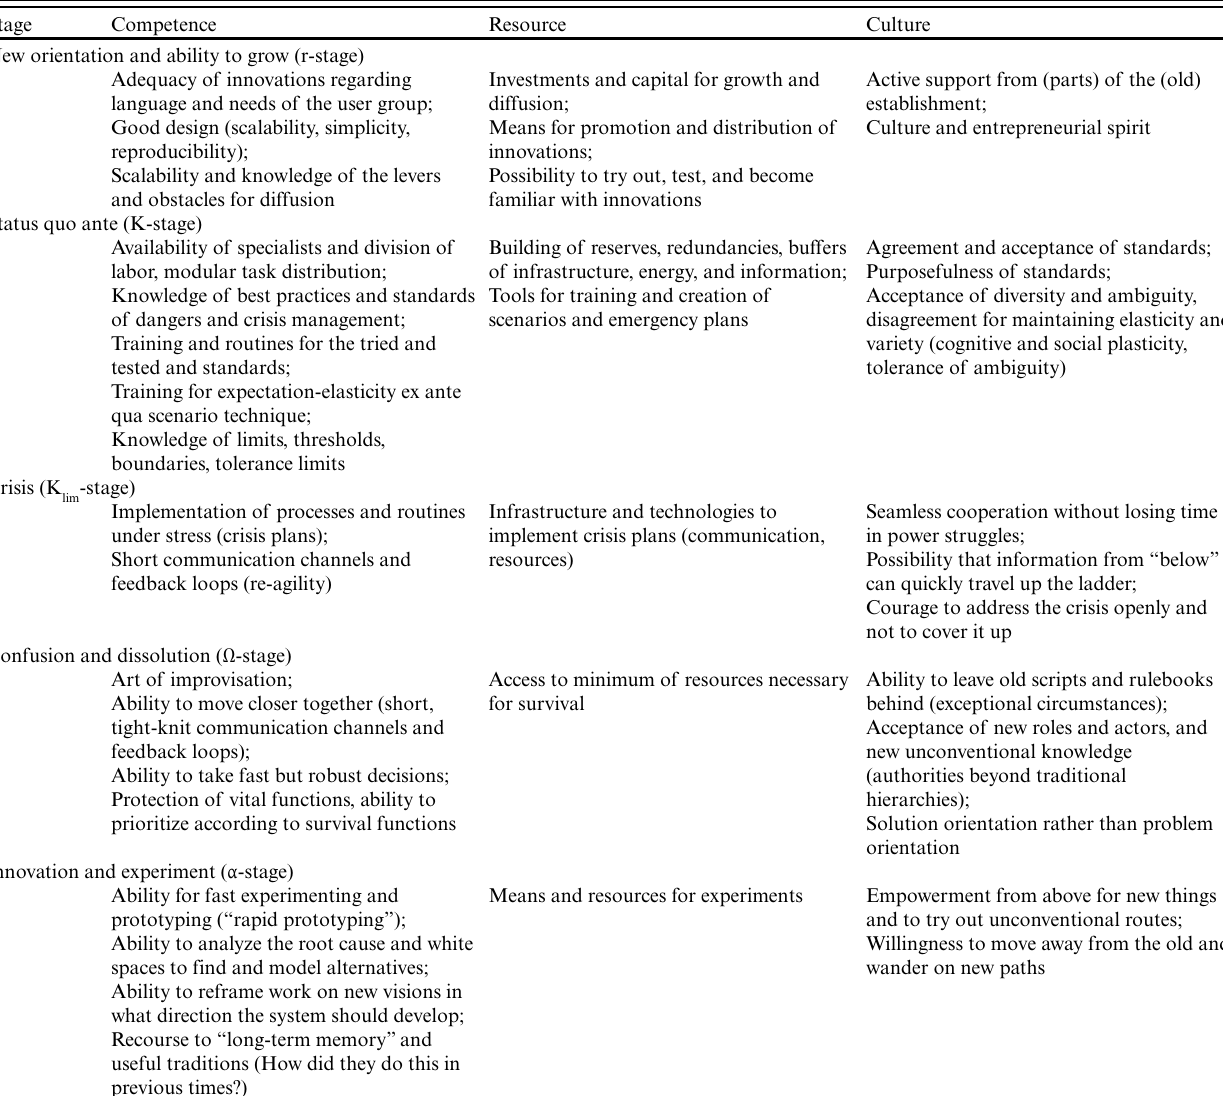
Table 3. Competences, resources, and culture aiding navigation through the adaptive cycle applied to business management.